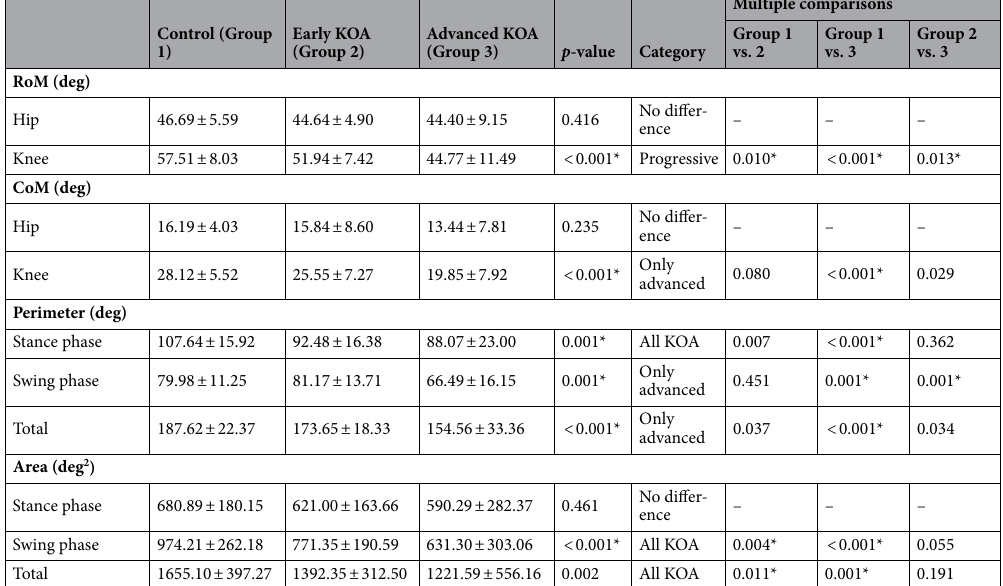
Early KOA (Group 2)